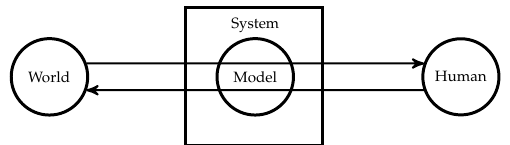
Figure 7. Data flow in a “ transmitted experience ” (adapted from Robinett [4]).